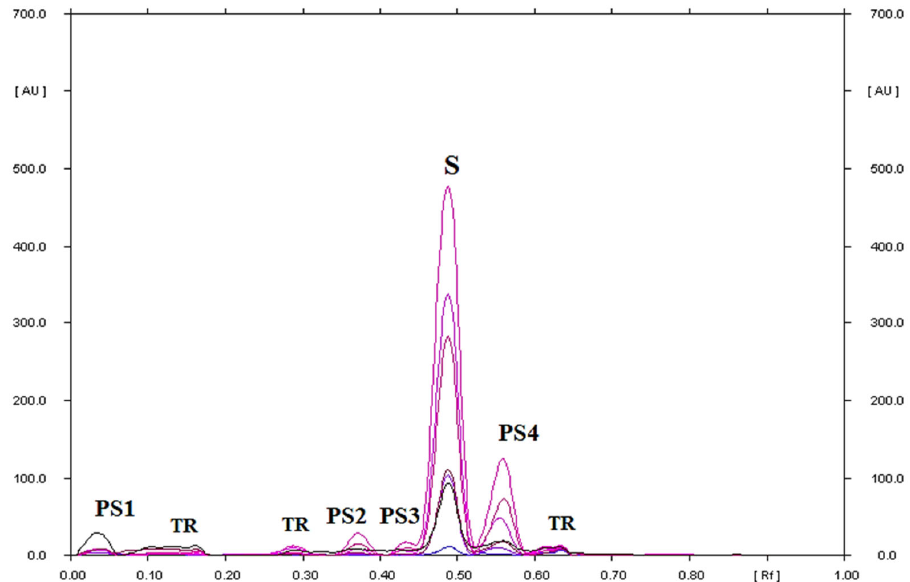
Figure 9. TLC-UV densitograms recorded in the multi wavelength from 200 to 380 nm (at wavelength intervals of 30 nm at each step) of secnidazole in hydrogen peroxide (3%) solution, which after heating at 40 ◦ C for 1000 h was separated on silica gel using a mobile phase chloroform–methanol (9:1, v / v ), where S is secnidazole, PS1, PS2, PS3, and PS4 are the degradation products of secnidazole, and TR is the traces; PS2 was identified as 2-methyl-5-nitroimidazole.